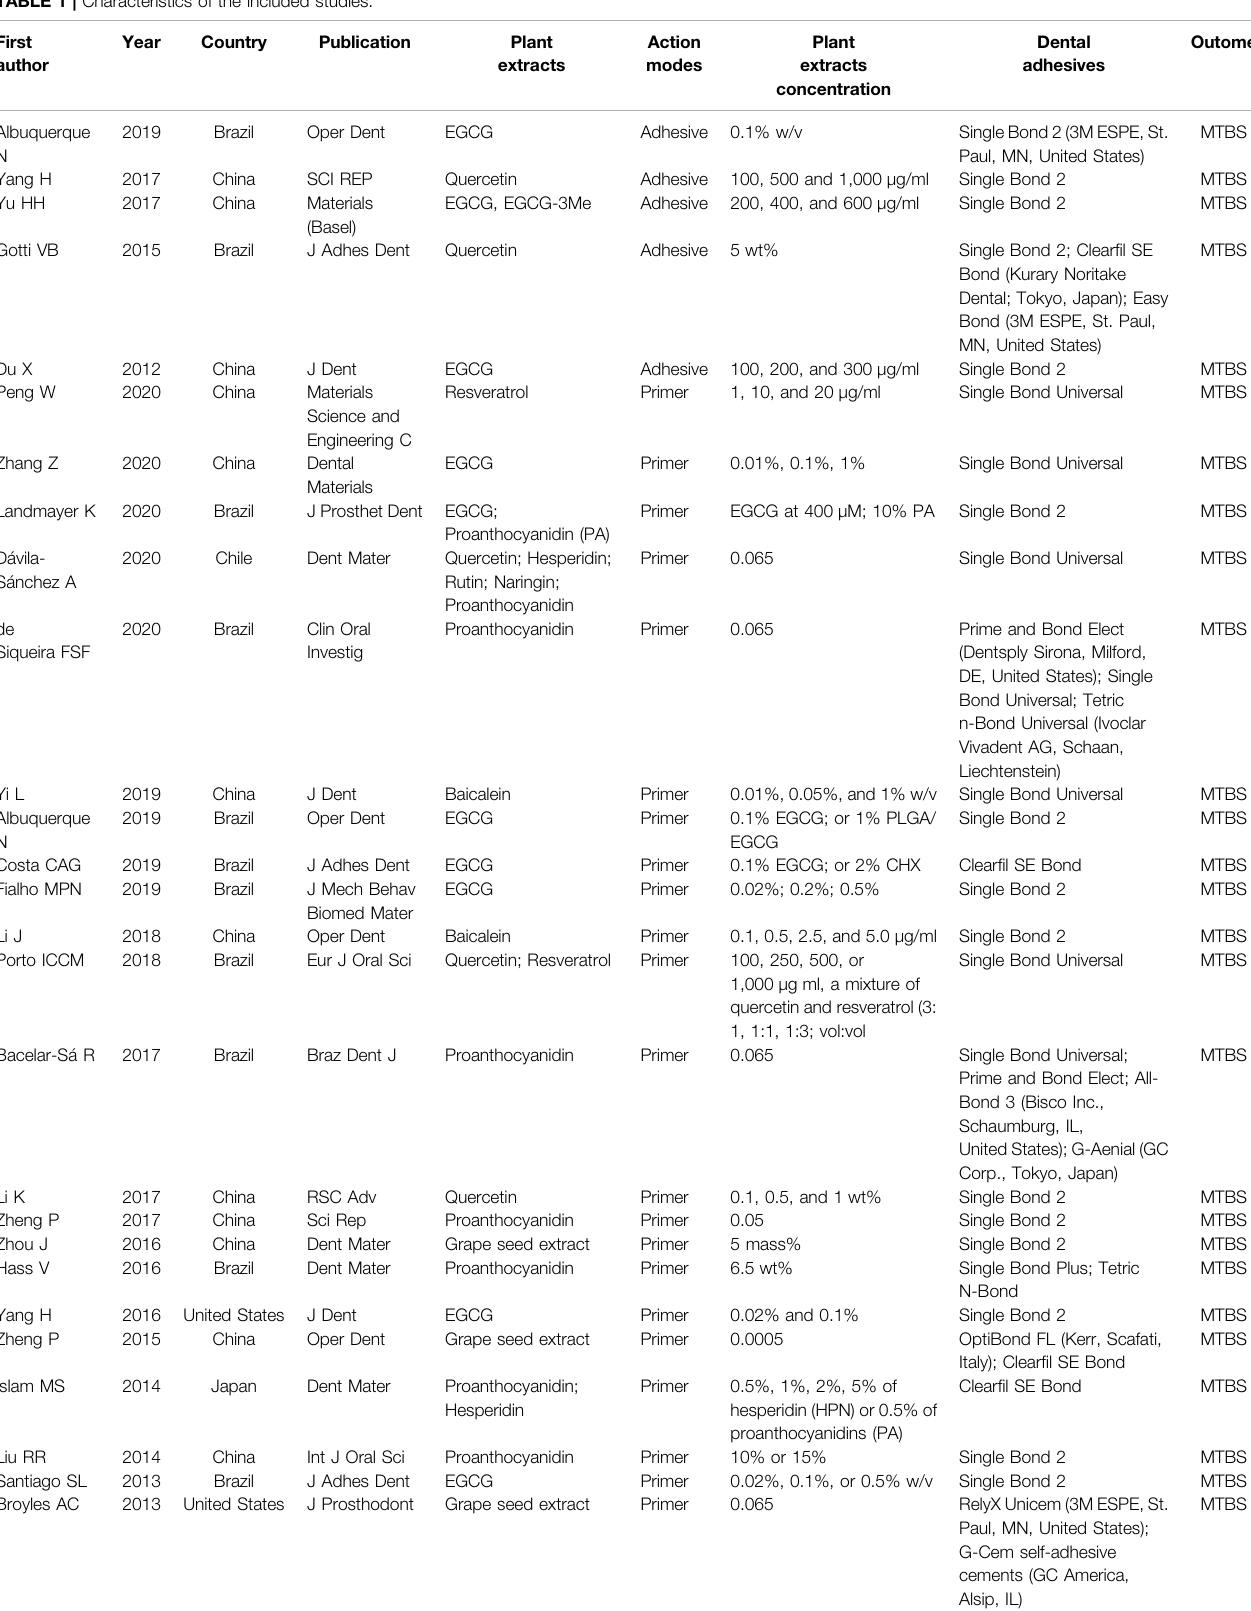
TABLE 1 | Characteristics of the included